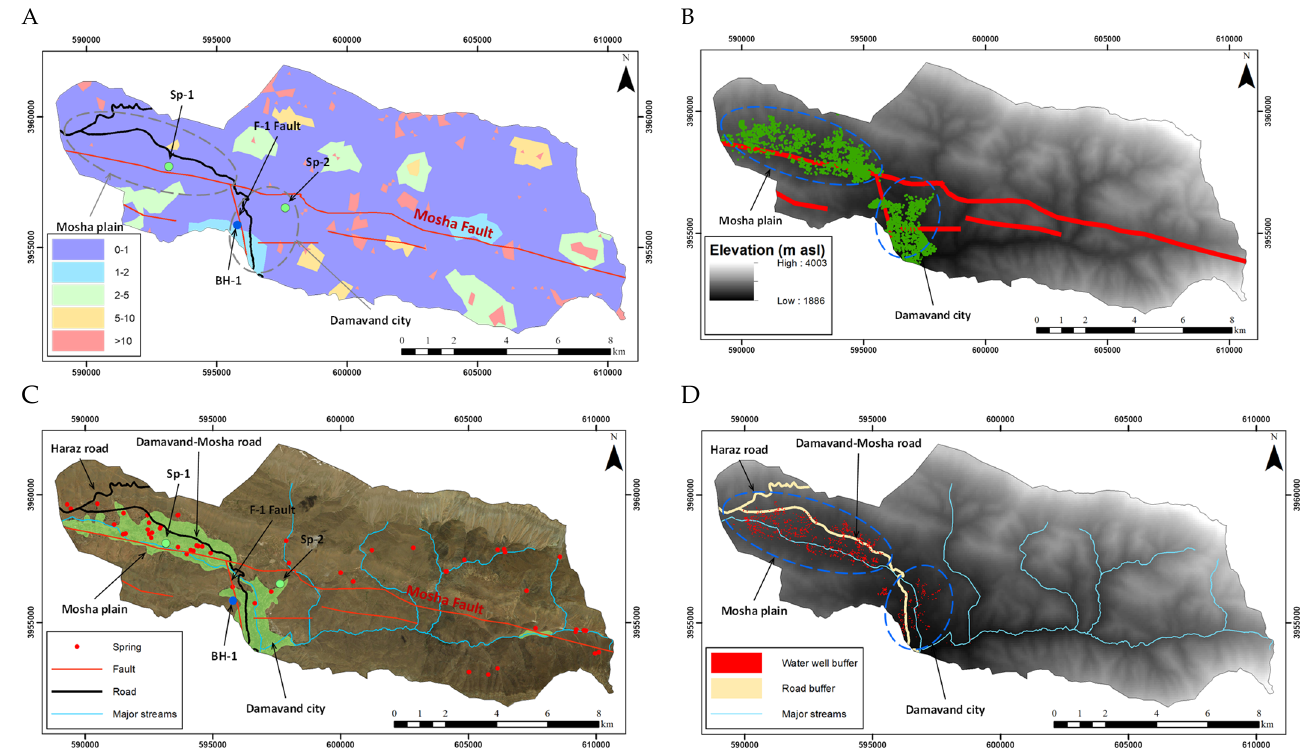
Figure 4. The maps indicate the groundwater vulnerability and hazard zones in the study area. Solid black lines represent major inter ‐ city roads: ( A ) a map showing the fracture density in the study area (values are in fractures per m 2 ); ( B ) the municipal pit latrines with a 50 m buffer zone; ( C ) a map showing the land use in the study area. The green patches show the municipal areas; ( D ) the groundwater abstraction wells with a 20 m buffer zone.